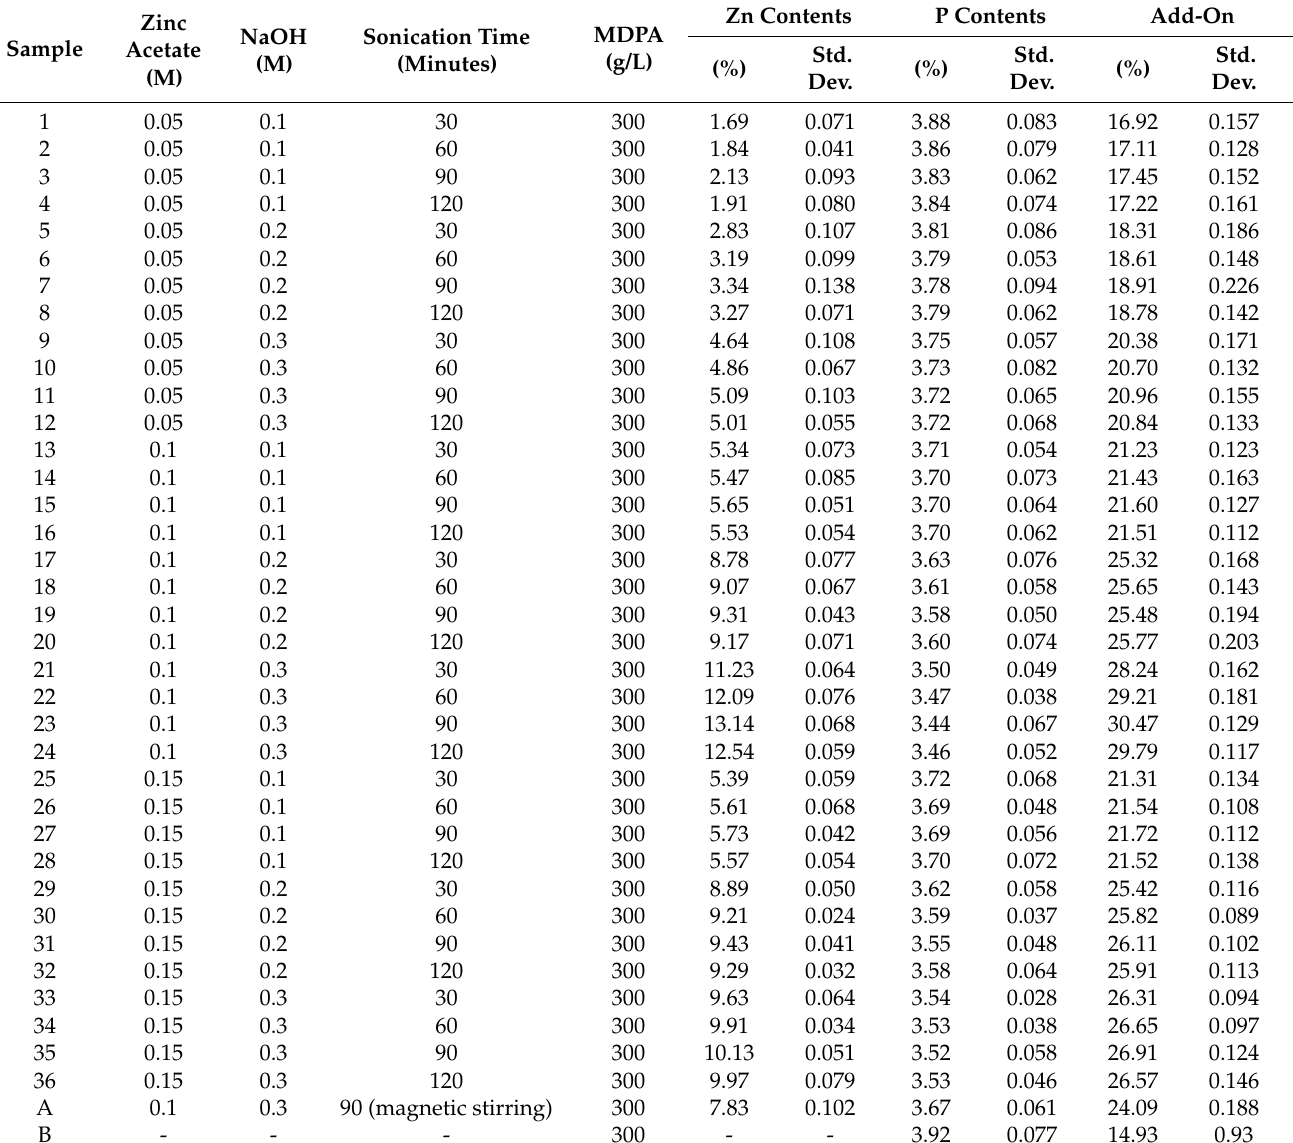
Table 1. Molar concentrations of the precursors, sonication time, MDPA, resulting Zn contents, P contents, and add-on